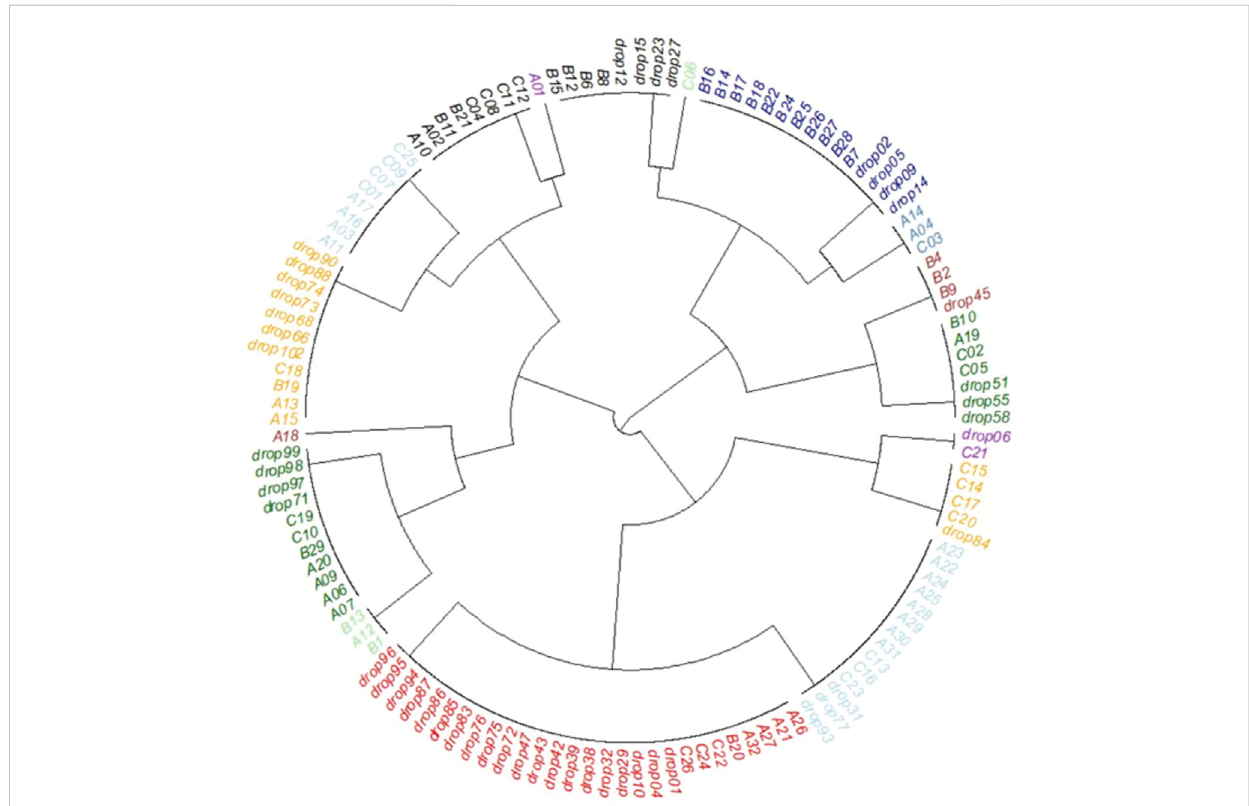
FIGURE 9 Cluster analysis (clockwise direction starting on C06): Bioencrustation on paleovalley margin (cyan); Rhodoliths on valley margin and depression (dark blue); Bioencrustation on shallower valley bottom (petroleum blue); Rhodoliths on deeper valley bottom (brown); Unconsolidated sediment on deeper valley bottom (dark green); Rhodoliths on fl at bottom (purple); Unconsolidated sediment on fl at bottom (orange); Rhodoliths with sediments on fl at bottom (cyan); Mäerl on fl at bottom (red), Rhodoliths with sediments on shallower valley bottom (light green); Rhodoliths with sediments on depression and valley margin (dark green); Rhodoliths with sediments on deeper valley bottom (brown); Mäerl on valley margin and depression (orange); Unconsolidatedsedimentondepressionandvalleymargin(cyan);Unconsolidatedsedimentonshallowervalleybottom(black);Mäerlonshallowervalley bottom (purple); Rhodoliths on shallower valley bottom